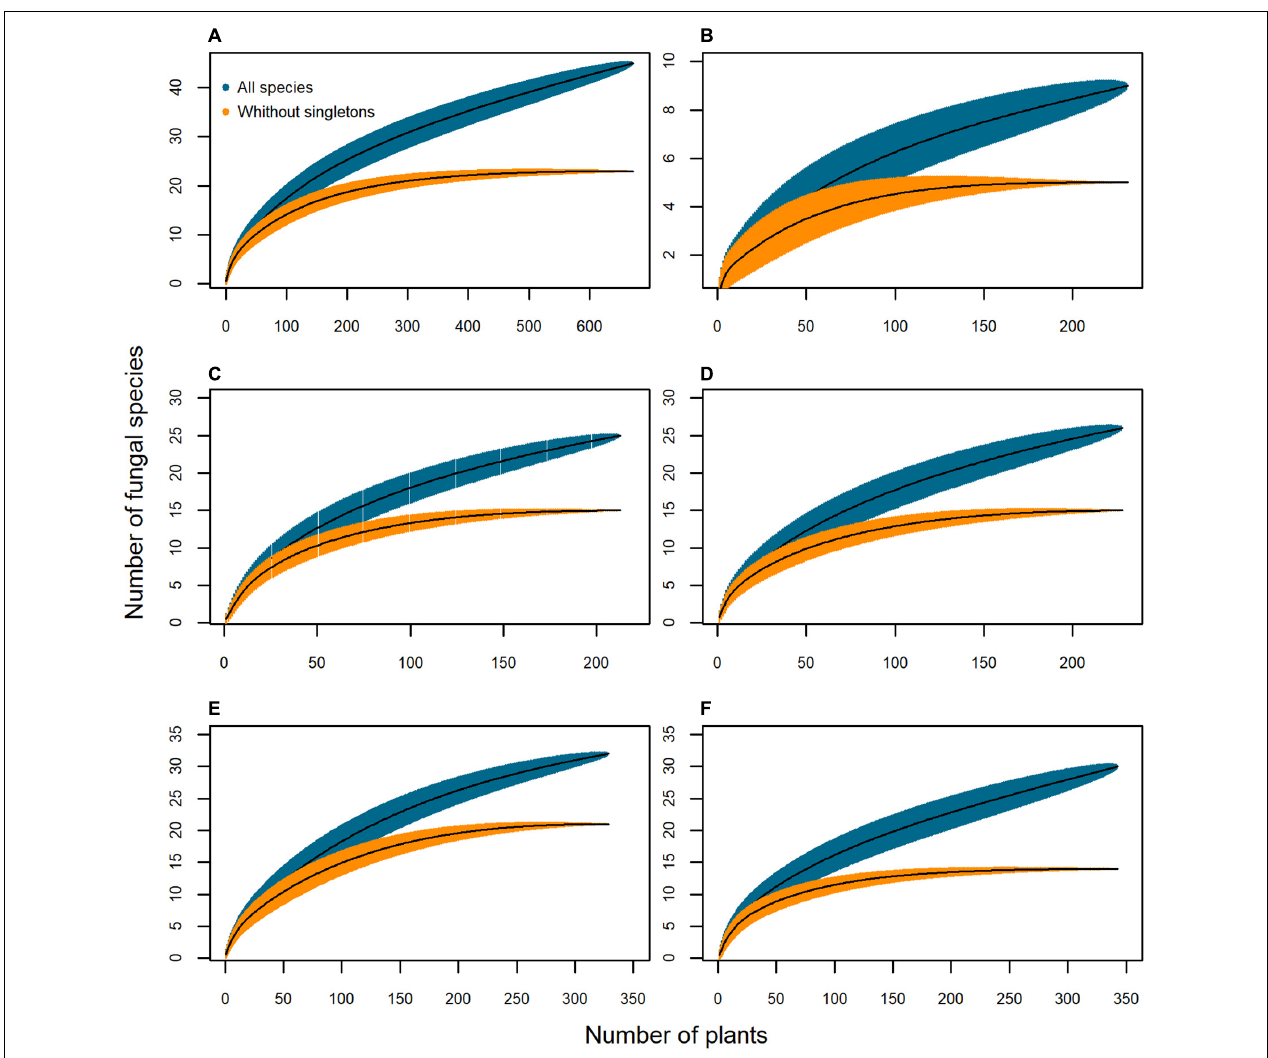
FIGURE 3 | Species-accumulation curves of the mycobiota isolated from Brachypodium rupestre according to plant tissue and grassland type. Black line, based estimator of the total number of species; shaded zone, standard deviation; dark blue, all species included; orange, excluding singleton species. (A) All tissues, (B) Shoots, (C) Rhizomes, (D) Roots, (E) Low-diversity grasslands, (F) High-diversity